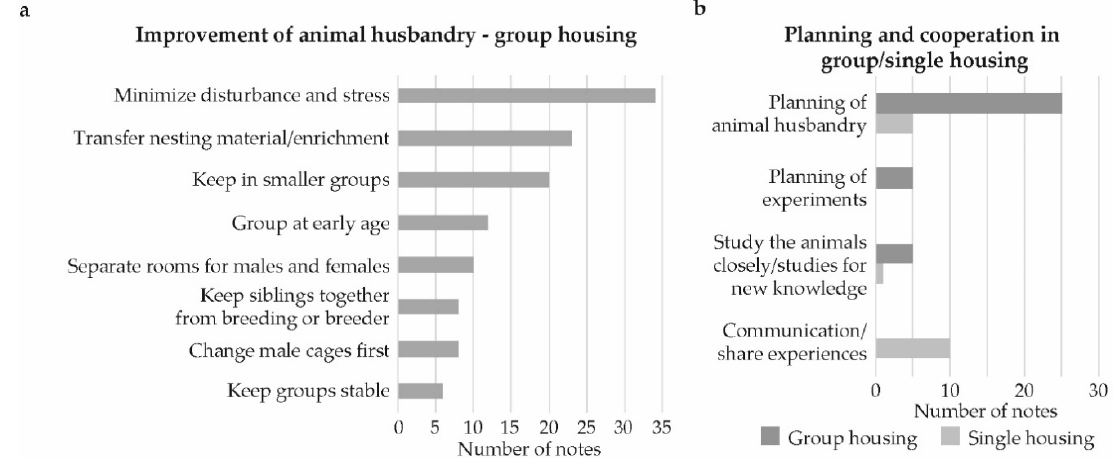
Figure 4. Problem solving for group and single housing of male mice. Number of comments per subcategory for problem solving for: ( a ) Group housing of male mice by certain routines or improvements in animal husbandry and, ( b ) Subcategories for planning and cooperation for both group and single